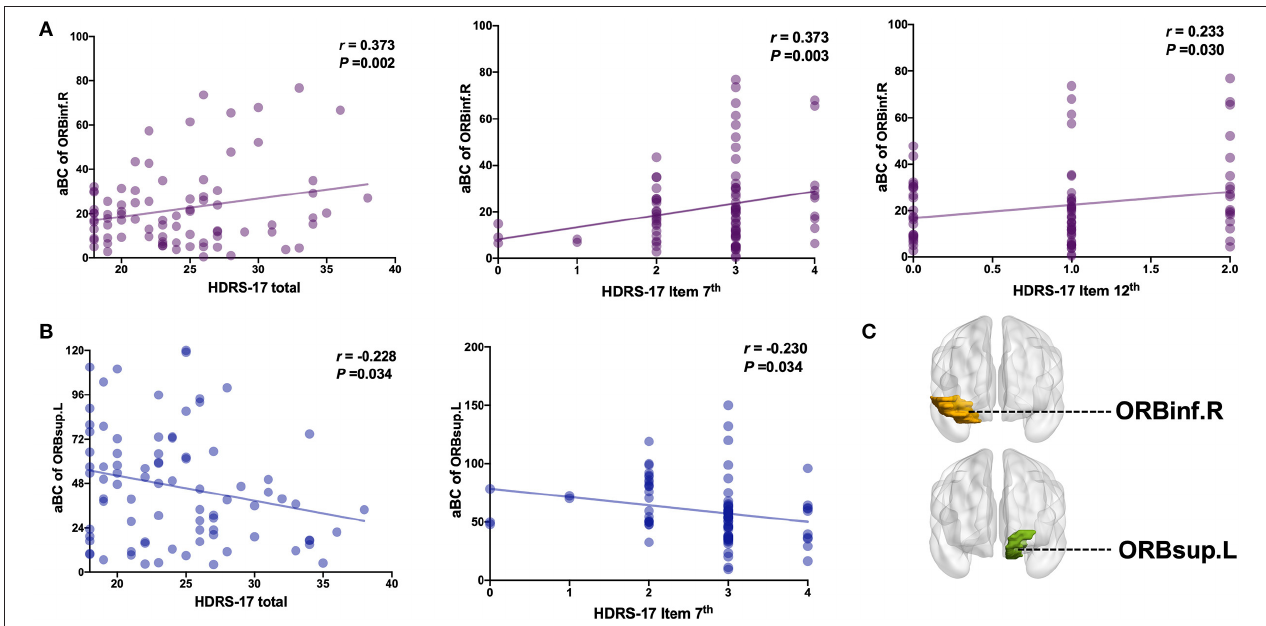
FIGURE 3 | Correlation analysis of HRSD-17 factor scores on aBC of ORBinf.R and ORBsup.L. (A) aBC of ORBinf.R is positively correlated with HRSD-17 total score or factor score. (B) aBC of ORBsup.L is negatively correlated with HRSD-17 total score or factor score. (C) Brain regions visualization. L, Left hemisphere; R, Right hemisphere; ORBinf (Purple, Orbital inferior frontal gyrus); ORBsup (Blue, Orbital superior frontal gyrus). HRSD Item 7th (0–4 score): Reduced Work and Activities; HRSD Item 12th (0–2 score): Gastrointestinal Somatic